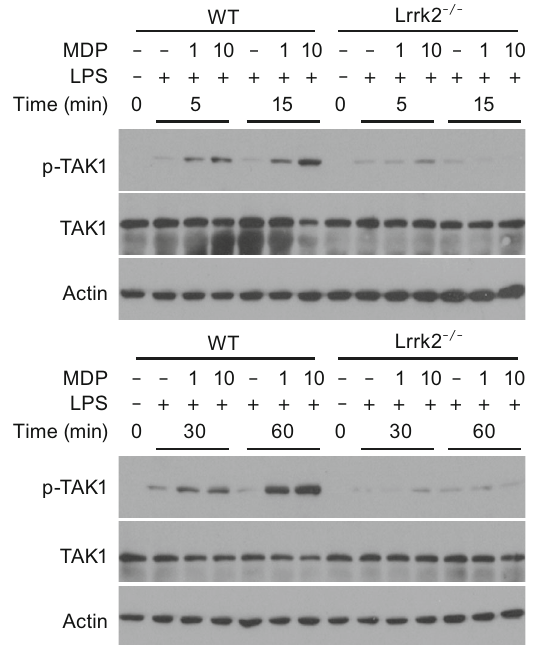
Figure 4. LRRK2 modulates TAK1 activation in BMDMs. The amounts of phosphorylated TAK1 and total TAK1 were determined by immunoblotting of lysates from WT and Lrrk2 − / − BMDMs treated with 5 ng/mL LPS and 1 or 10 μ g/mL MDP for the indicated times. Actin was used as a loading control. Data are representative of three independent